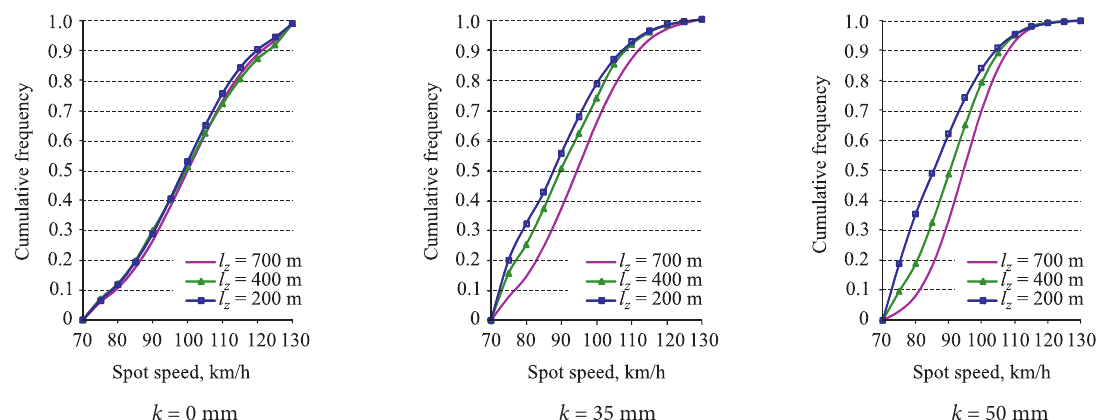
Fig. 2. Speed distribution functions for the road sections with various pavement conditions and the benchmark bendiness of 5 �/km